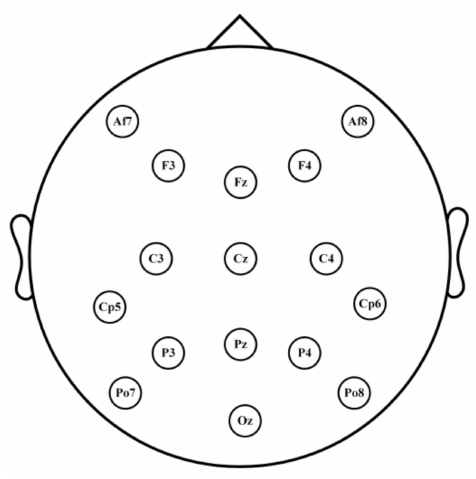
Figure 5. Electrode positions of the 16